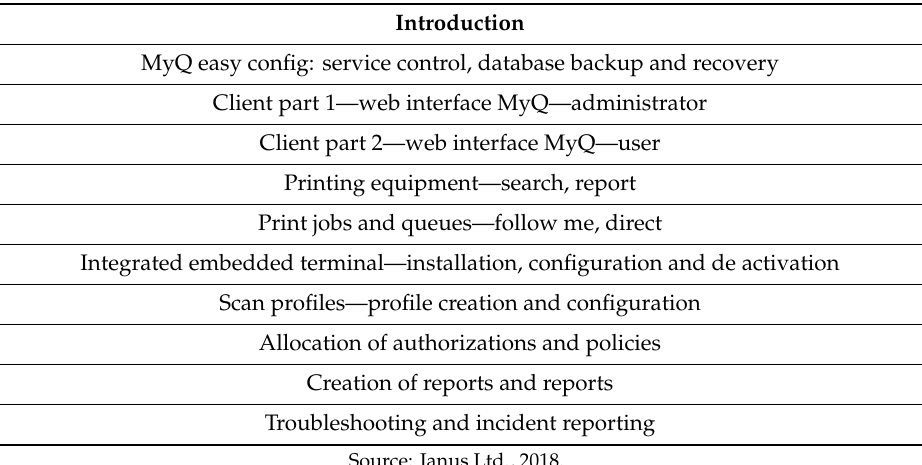
Table 8. Training content provided by the supplier.